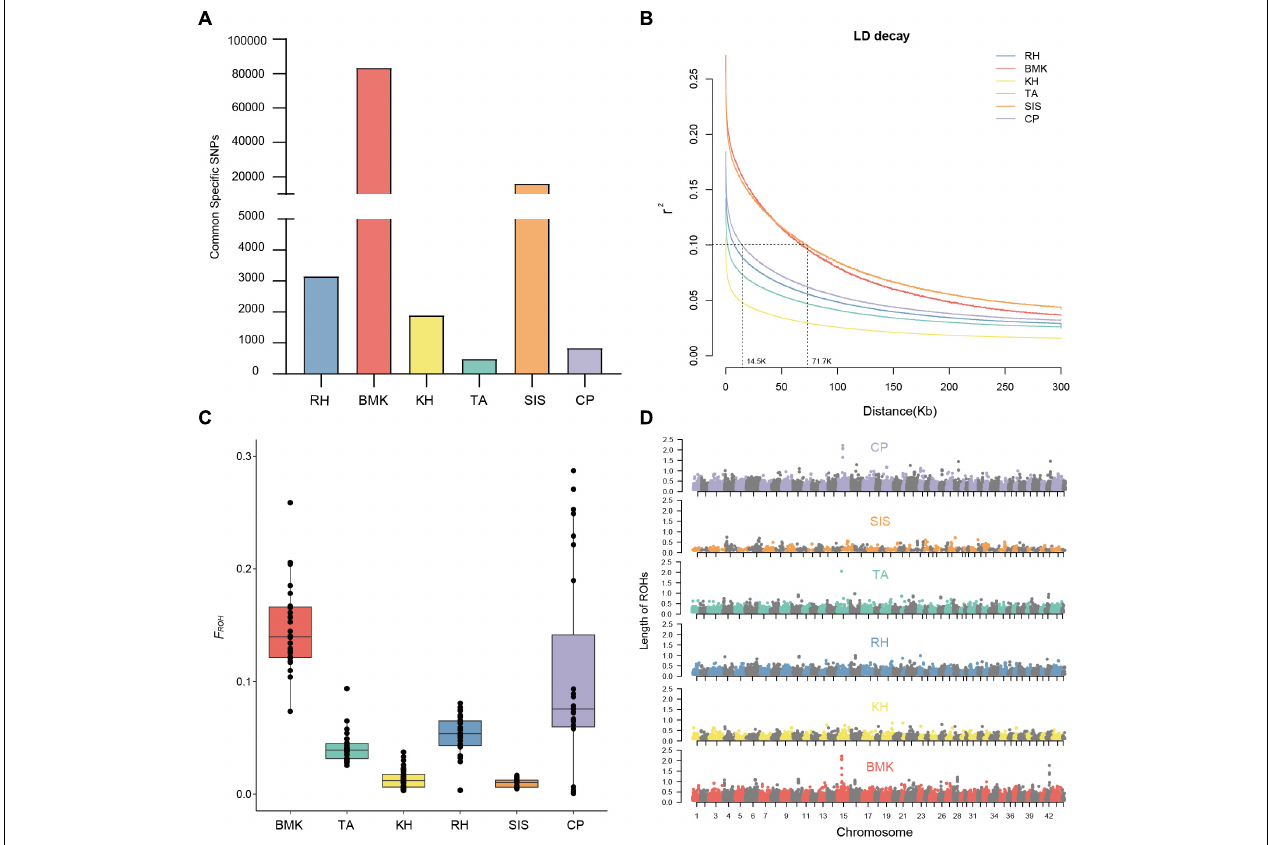
FIGURE 2 | (A) cps-SNPs among the six populations. (B) linkage disequilibrium (LD) decay at a distance of 0–300Kb. (C) Box plot of F ROH statistic. (D) Genome-wide distribution of ROHs in the six populations.